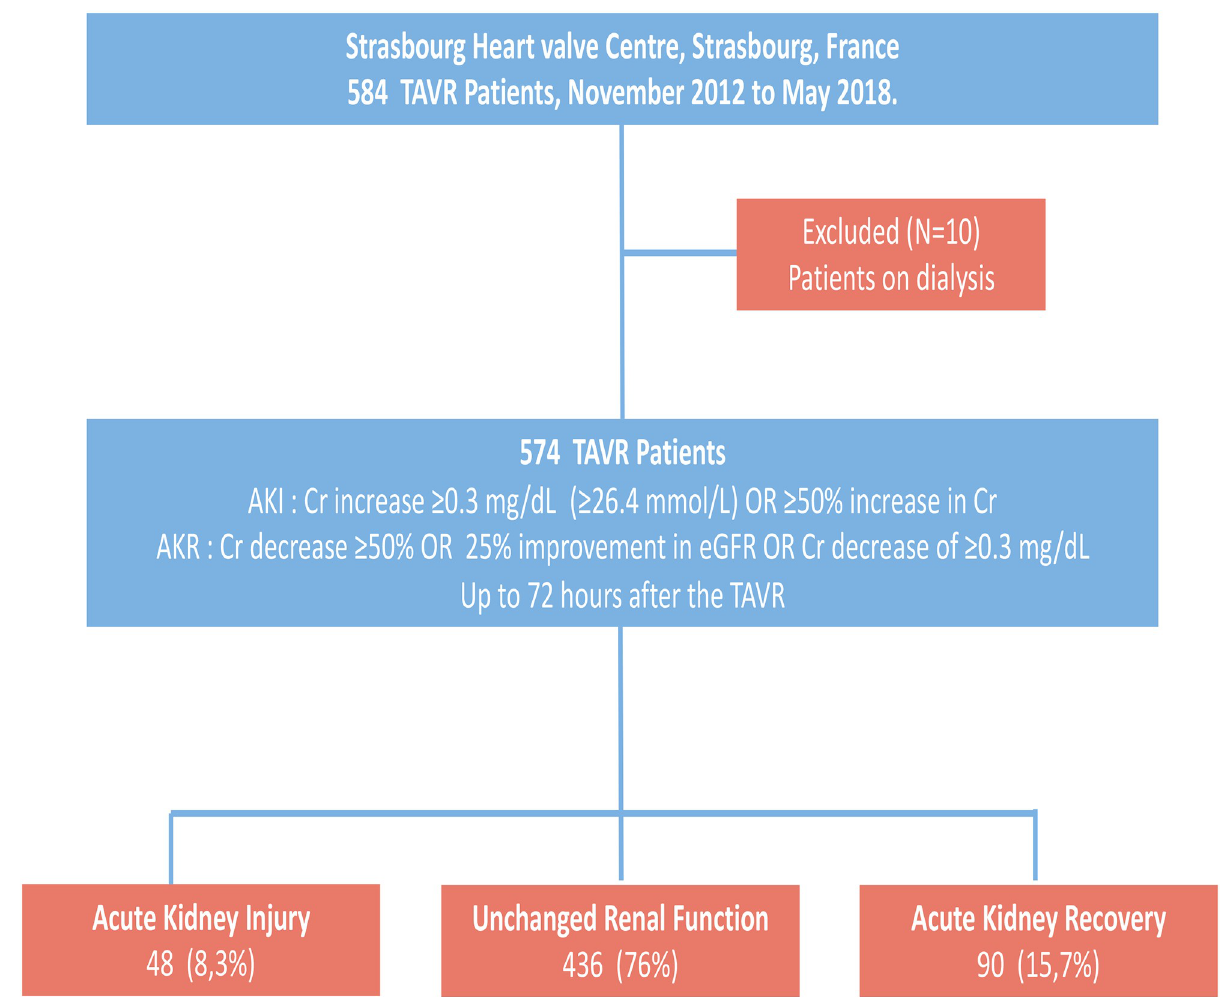
Fig 1. Flow chart of the study. Acute kidney injury and Acute kidney recovery following TAVR in a large cohort registry. Among 574 TAVR patients, Acute Kidney Injury (AKI) was documented for 8.3%, Acute Kidney Recovery (AKR) for 15,7% and unchanged renal function for 76% of the global